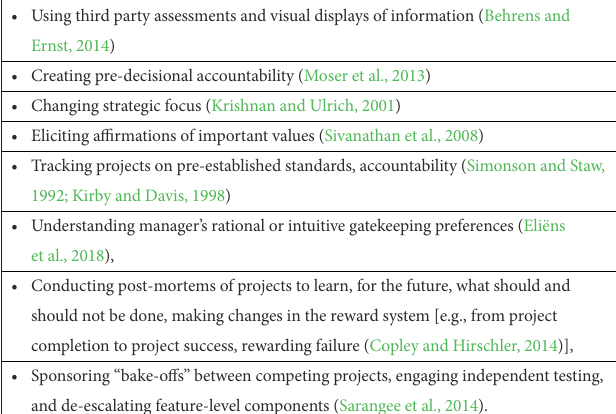
TABLE 2 Research-based techniques for terminating initiatives.